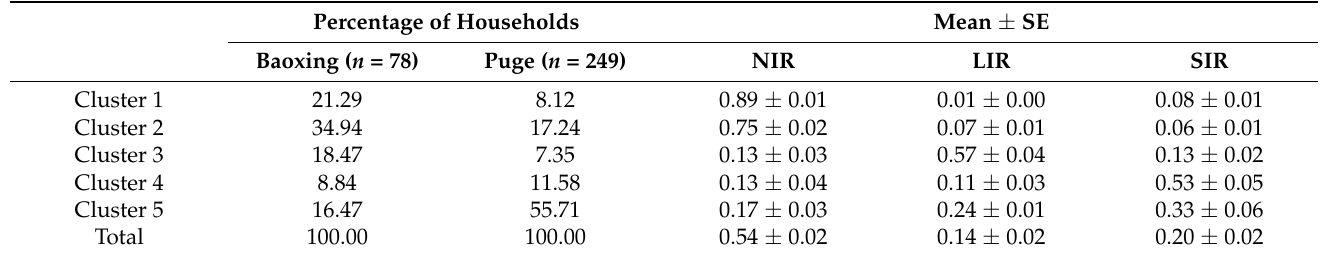
Table 4. Distribution of household clusters derived from the Two-Step cluster